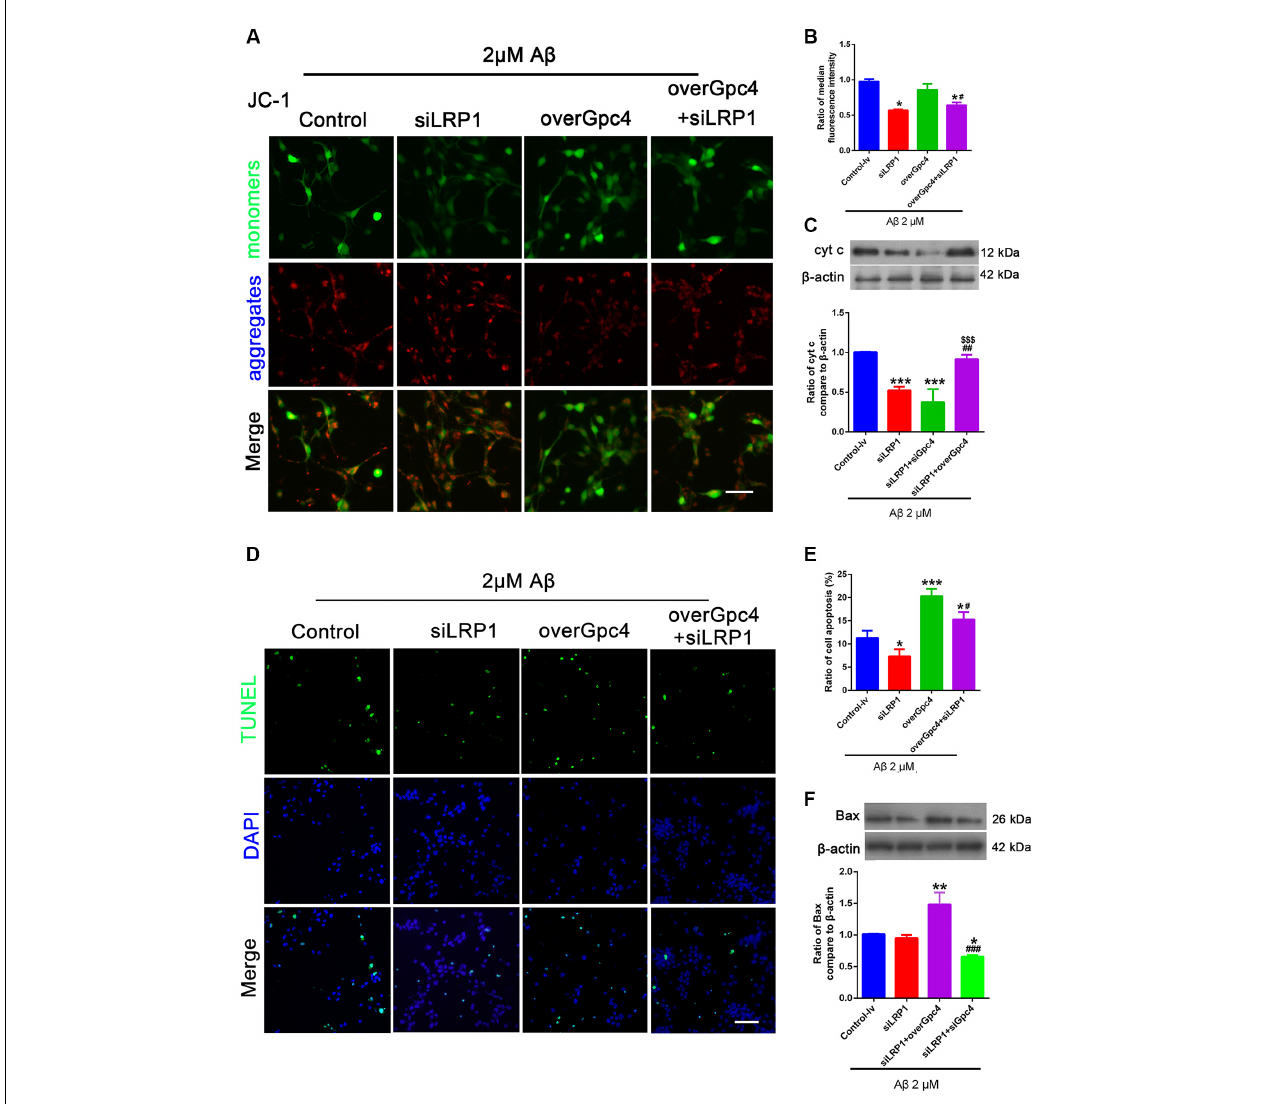
FIGURE 7 | Gpc4 regulates cell apoptosis partly via LRP1 in NSCs. (A,B) NSCs were infected with control, siLRP1, overGpc4, and overGpc4 + siLRP1 AdV for 3 days, and 2 µ M A β was added for 12 h. The JC-1 kit was used to detect the mitochondrial membrane potential in NSCs. JC-1 monomers (green) and aggregates (red) were compared and normalized to the control group. The ratio of monomers to aggregates was calculated. (C) Seventy-two hours after AdV infection, 2 µ M A β 42 was added to the control, siLRP1, siLRP1 + siGpc4, and siLRP1 + overGpc4. The levels of Cytc were determined using western blotting. *** represents siLRP1 + siGpc4 vs. control, P = 0.0001, siLRP1 vs. control, P = 0.0007; siLRP1 + overGpc4 vs. siLRP1, P = 0.0028. $$$ siLRP1 + siGpc4 vs. siLRP1 + overGpc4, P = 0.0252, *siLRP1 + siGpc4 vs. siLRP1 + overGpc4, P = 0.0003. (D,E) NSCs were infected with control, siLRP1, overGpc4, and overGpc4 + siLRP1 AdV for 3 days, and A β was added for 12 h. TUNEL staining was used to detect whether Gpc4 regulated A β -induced cell death via LRP1. The ratio of apoptotic cells was calculated based on TUNEL positive cells (green) and DAPI (blue). (F) The expression of Bax was also detected using western blotting, ** represents siLRP1 + overGpc4 vs. siLRP1, P = 0.0007, *siLRP1 + siGpc4 vs. siLRP1, P = 0.0252, *siLRP1 + siGpc4 vs. siLRP1 + overGpc4, P < 0.0001. GPc4, glypican 4; LRP1, low-density lipoprotein receptor related protein 1; NSCs, neural stem cells; DAPI, 4 (cid:48) ,6-diamidino-2-phenylindole; AdV, adenovirus; TUNEL, terminal deoxynucleotidyl transferase dUPT nick end